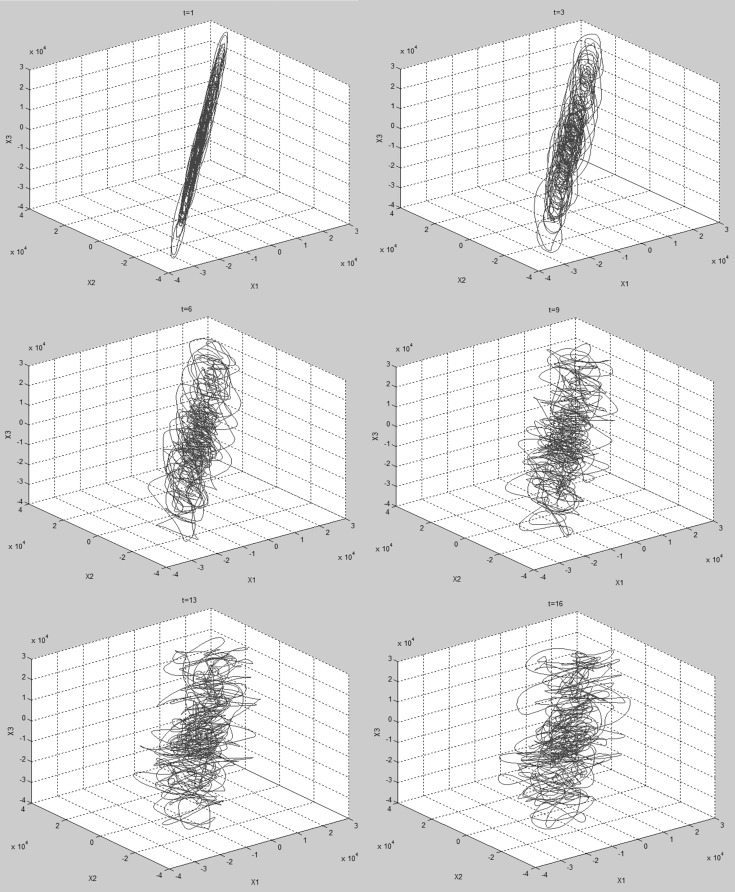
Reconstructed phase space trajectories of a VEP recorded with 3606 Hz sampling frequency embedded in 3 dimensional phase space using different values of τ.From top left to bottom right, τ = 1, 3, 6, 9, 13, 16, 19, 22.